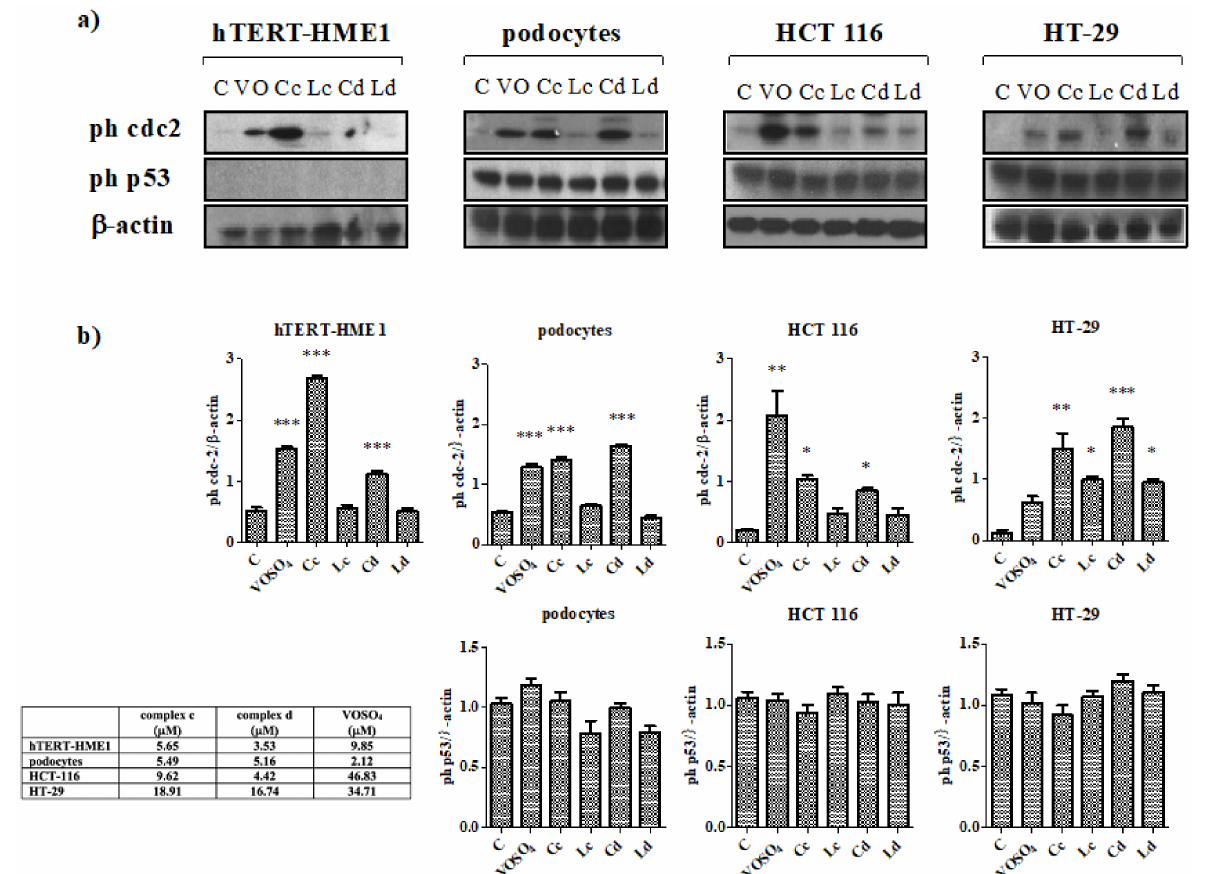
Figure 4. Modulation of cell cycle-related protein by vanadyl complexes. ( a ) Phosphorylation of cell cycle-related proteins was evaluated via immunoblot analysis. Cells were treated with complexes, ligands, or VOSO 4 for 24 h. All compounds were used at the IC 50 calculated from the antiproliferative assay, and ligands were used at the same concentrations of the respective complex. VOSO 4 was used at the IC 50 calculated from the previously conducted antiproliferative assays or at the maximum concentration if the 50% of proliferation inhibition was not reached. The used concentrations are reported in the table presented in the figure. β -actin was used to confirm the homogeneity of the protein loaded. Immunoblot was representative of three performed experiments. ( b ) Densitometric analyses were performed using ImageJ. Values are presented as the means ± standard deviation (S.D.); n = 3; * p < 0.05; ** p < 0.01; *** p < 0.001 vs. control (C). VO: VOSO 4 ;